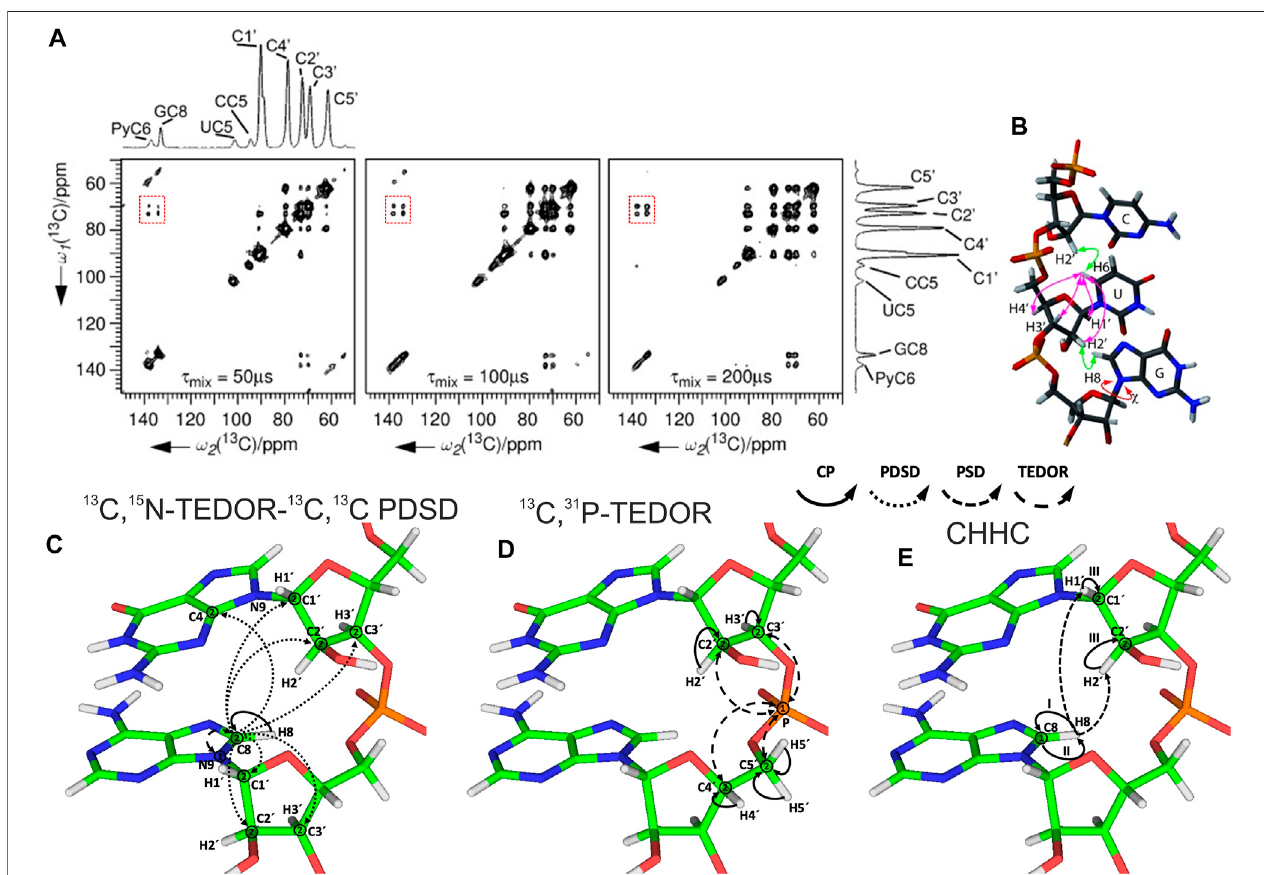
FIGURE 8 | Sequential assignment of RNA by ssNMR. (A) CHHC spectra of (CUG) 97 RNA acquired at different mixing times. The assignments of the different resonancesareindicatedonthespectralprojectionshown.Sequentialcorrelationsarehighlighted. (B) Intra-andinternucleotide 1 H – 1 Hcorrelationsinadouble-stranded A-formhelical RNA(Riedel et al., 2006). (C – E) Magnetizationtransferin (C) 13 C, 15 N-TEDOR- 13 C, 13 CPDSD, (D) 13 C, 31 PTEDOR,and (E) CHHC experiments shown on the example of sequential guanosine and adenosine (Marchanka et al., 2015). Solid arrows indicate CP transfers, dotted arrows indicate homonuclear 13 C, 13 C PDSD transfer, densely dashed arrows indicate PSD transfer, and dashed arrows indicated TEDOR transfer; Arabic numbers correspond to the spectral dimensions (t 1 – t 2 ); Roman numbers indicate CP transfers. Panels (A) and (B) are reprinted with permission from (Riedel et al., 2006) © John Wiley and Sons,